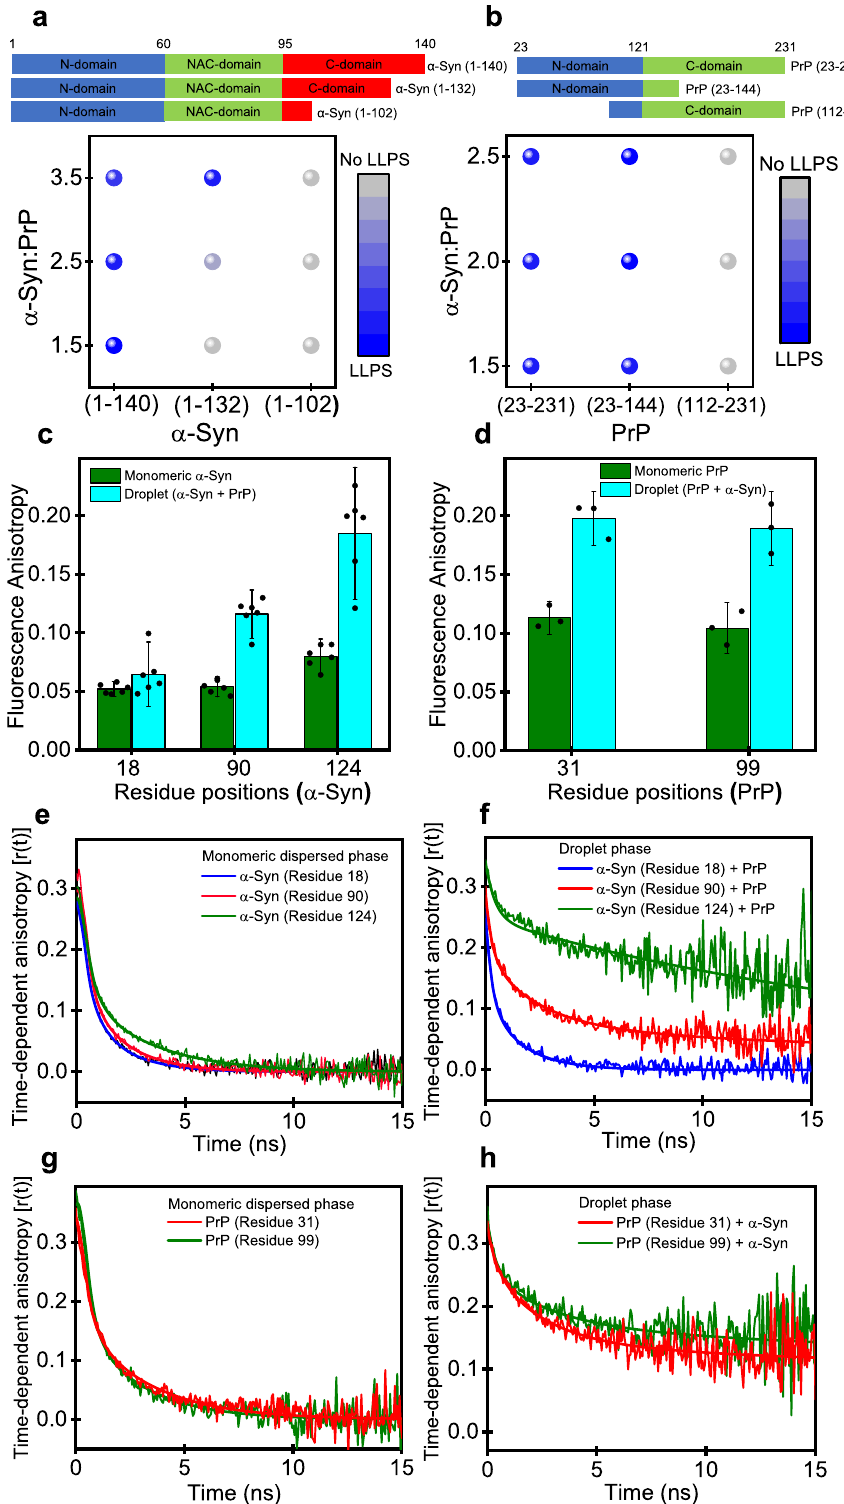
slower (nanosecond) rotational correlation time corresponding to the backbone dihedral rotations. For expanded IDPs, the slower correlation time represents a characteristic relaxation time (~1.4 ns) that arises due to short-range torsional fl uctuations in the Φ - Ψ dihedral space 63,64 . As expected, in the monomeric dispersed phase, α -Syn exhibited such typical location- independent biexponential fl uorescence depolarization kinetics